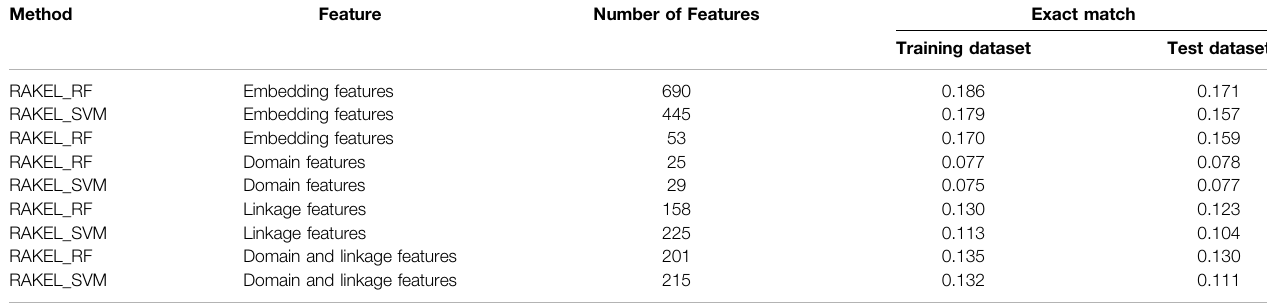
TABLE 3 | Exact match of the important multi-label classi fi ers with different features on training and test datasets.